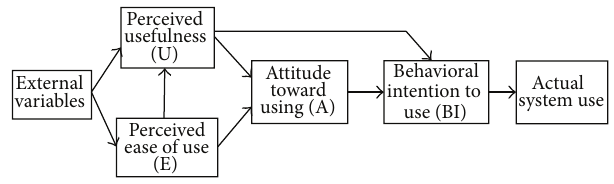
Figure 1: Technology acceptance model of Davis